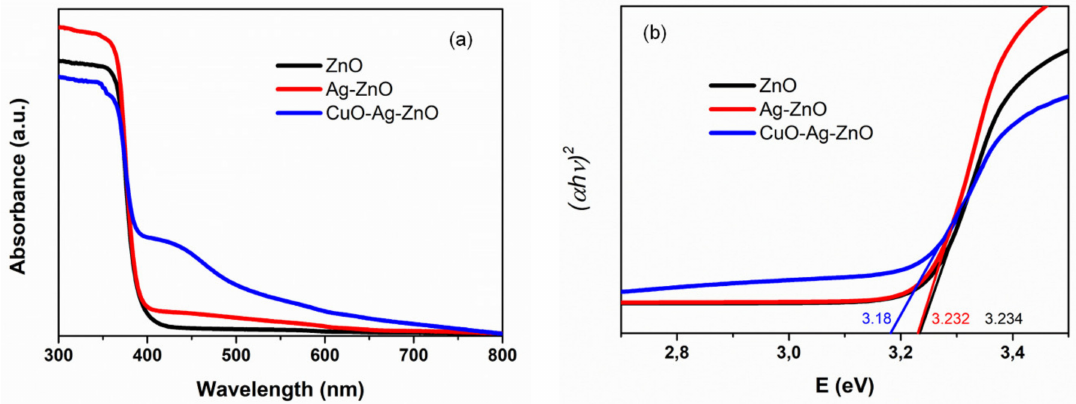
Figure 5. Absorbance spectra of samples ( a ), and Tauc plot for calculation of bandgap of samples ( b